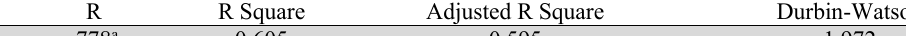
Correlation coefficient of the regression model Model